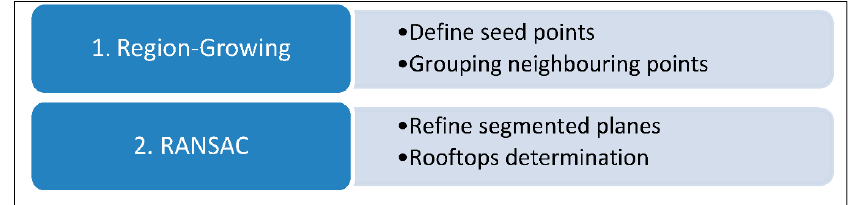
Figure 4. Schematic representation of the steps of the region-growing segmentation approach described in Section 2.3.